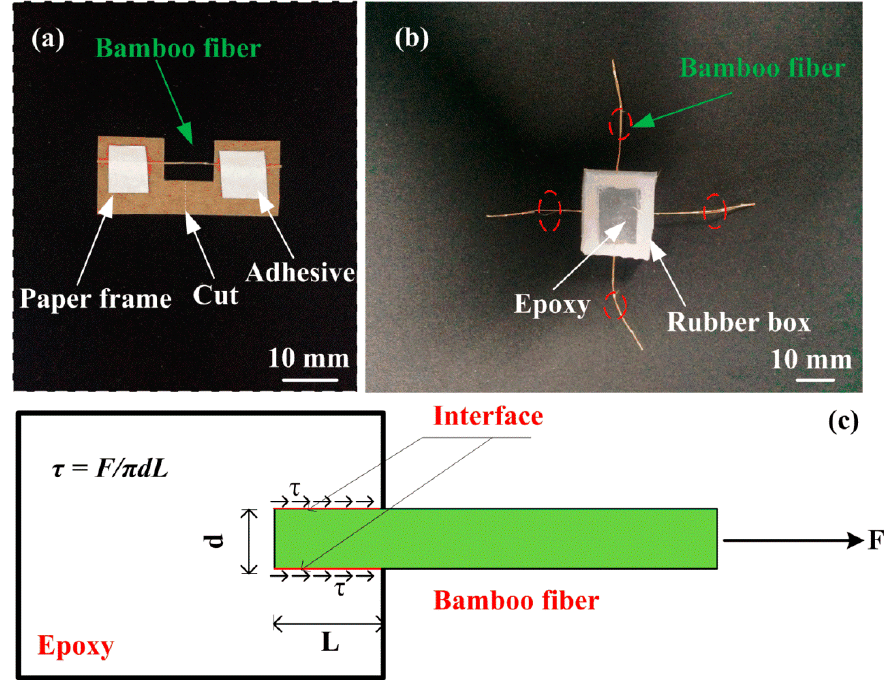
Figure 1. Schematic diagram illustrating: ( a ) Specimen for single fiber tensile test, ( b , c ) Schematic representation of the fiber pull-out specimen and test.